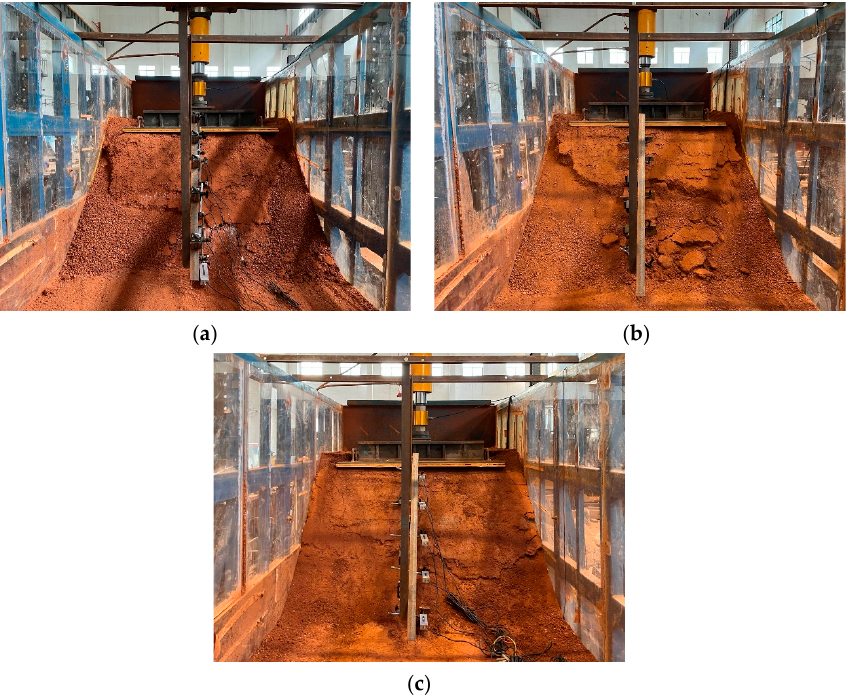
Figure 6. Slope failure after loading in each group of tests. ( a ) Test G1 plain soil slope. ( b ) Test G2 bamboo-rooted slope. ( c ) Test G3 rainfall bamboo-rooted slope. bamboo-rooted slope. ( c ) Test G3 rainfall bamboo-rooted